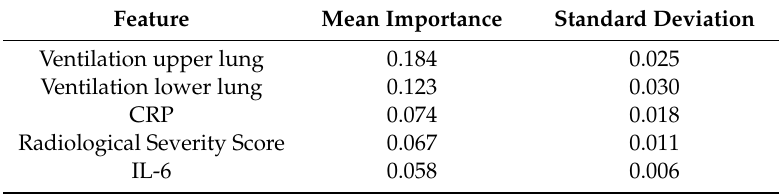
Table 3. Mean ± SD of random forest classification feature importance across the cross-validation